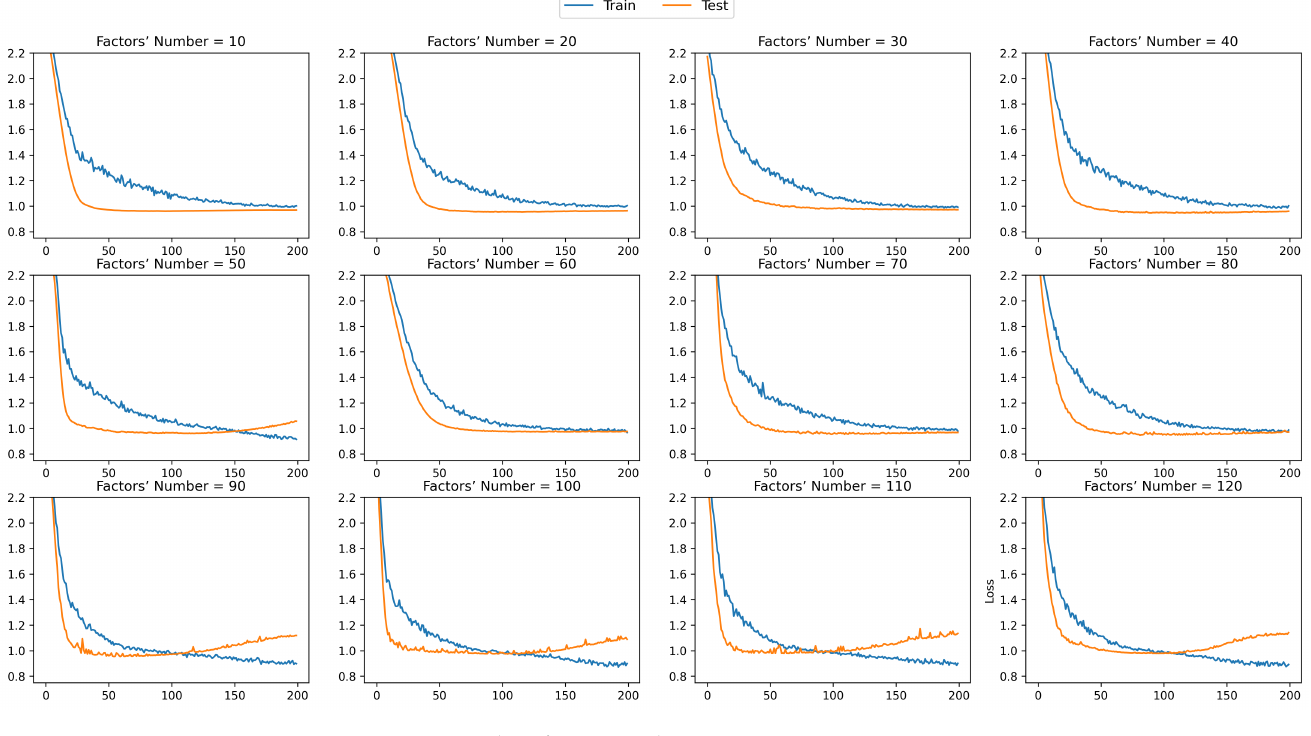
Figure 4. Loss values for Receipt log. Table 2. The highest AUC values of the 5 logs at different